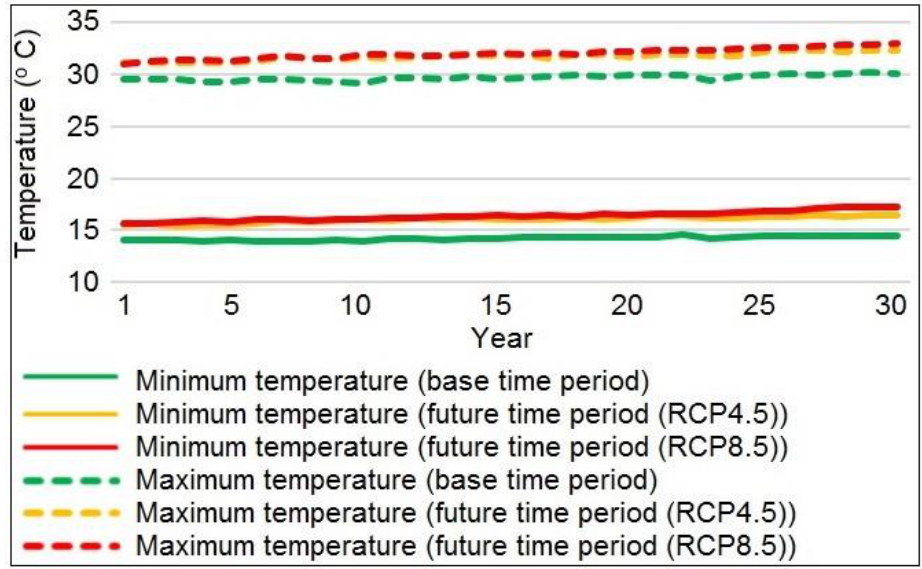
Figure 3. The annual minimum and maximum temperatures in the Lali region in the base and future time periods, considering RCP4.5 and RCP8.5 (years 1 – 30 indicate 1961 – 1991, as to the base time period and 2021 – 2050, as to the future time period).